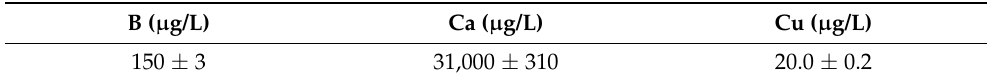
Table 3. Certified values for